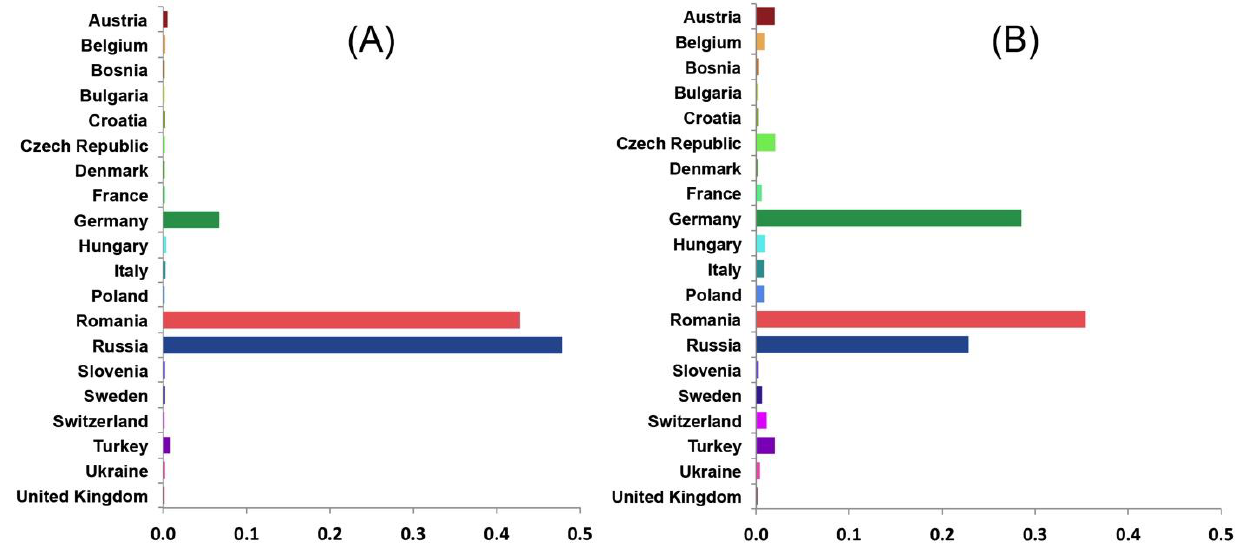
Figure 4. Posterior probabilities of ancestral areas of H5N1 HPAIV hemagglutinin (HA; A ) and neauraminidase (NA; B ) gene regions collected in Europe and the Russia.